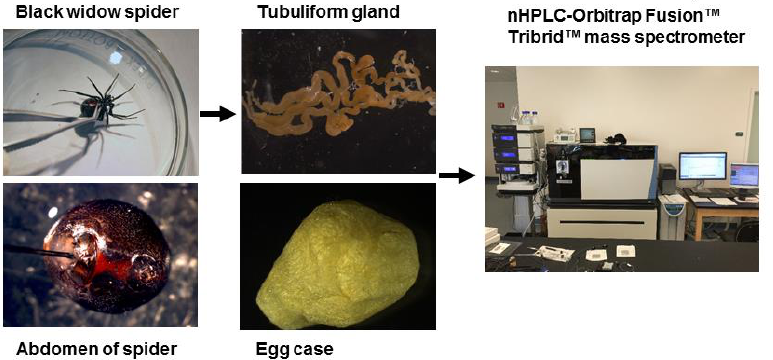
Figure 1. General workflow for isolation of the tubuliform gland, egg sac, and dope (liquid removed from the tubuliform glands), followed by analysis of the tryptic peptides by MS/MS